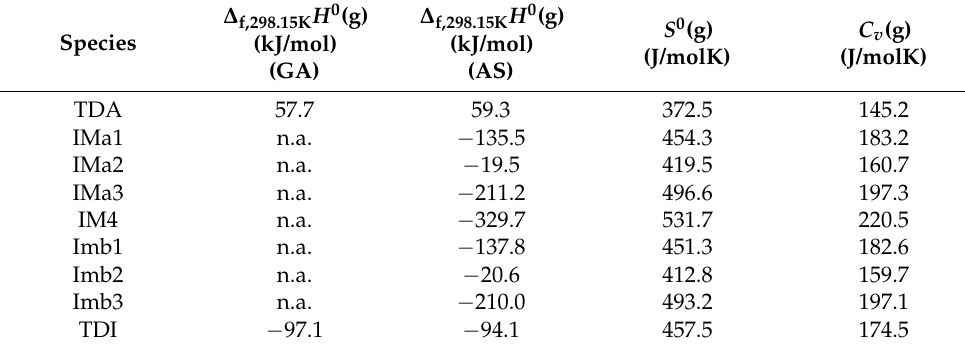
Table 2. Gas-phase thermochemical properties for intermediates of the phosgenation of the 2,4-TDA. The standard enthalpy of formation is calculated from G3MP2B3 enthalpies through group additivity (GA) role obtained by the means of online NIST tool [27] and through atomization scheme (AS). Standard molar enthalpy of formation ( ∆ f,298.15K H 0 (g)), standard molar entropy ( S 0 (g)), and molar heat capacity ( C v (g)) were obtained at 1 atm pressure at 298.15 K. Entropy and heat capacity values are obtained from scaled B3LYP/6-31G(d)